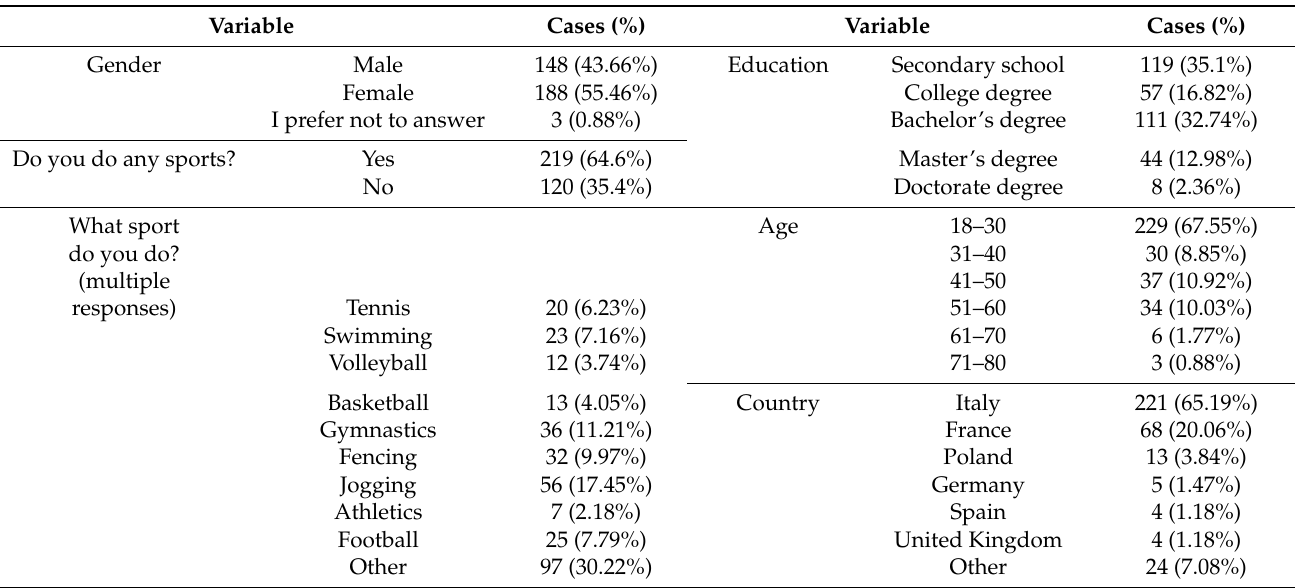
Table 1. Sample description.